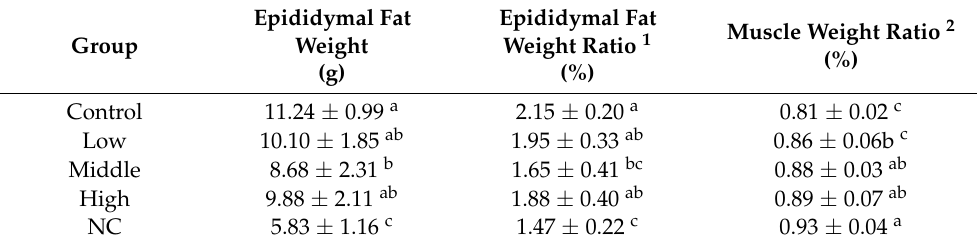
Table 3. Serum lipid profiles in SD rats. Group